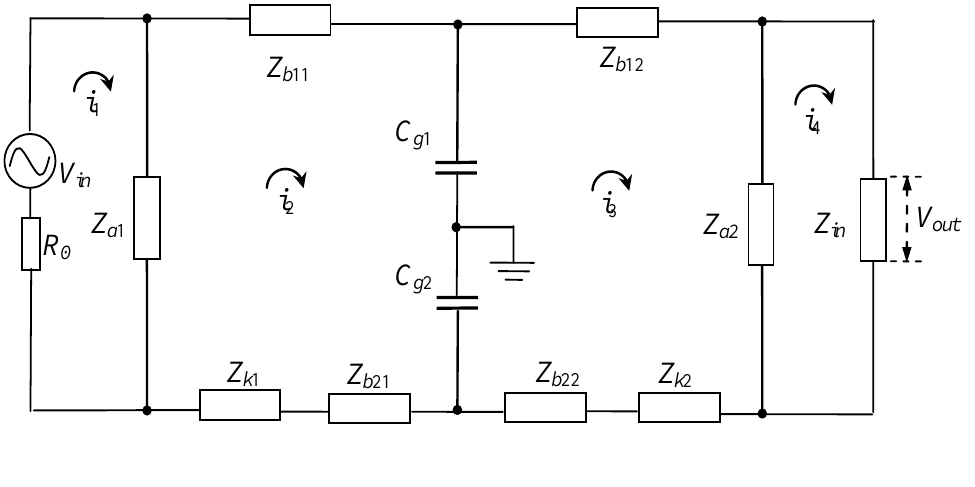
Figure 4. Equivalent circuit of implant IBC based on capacitive